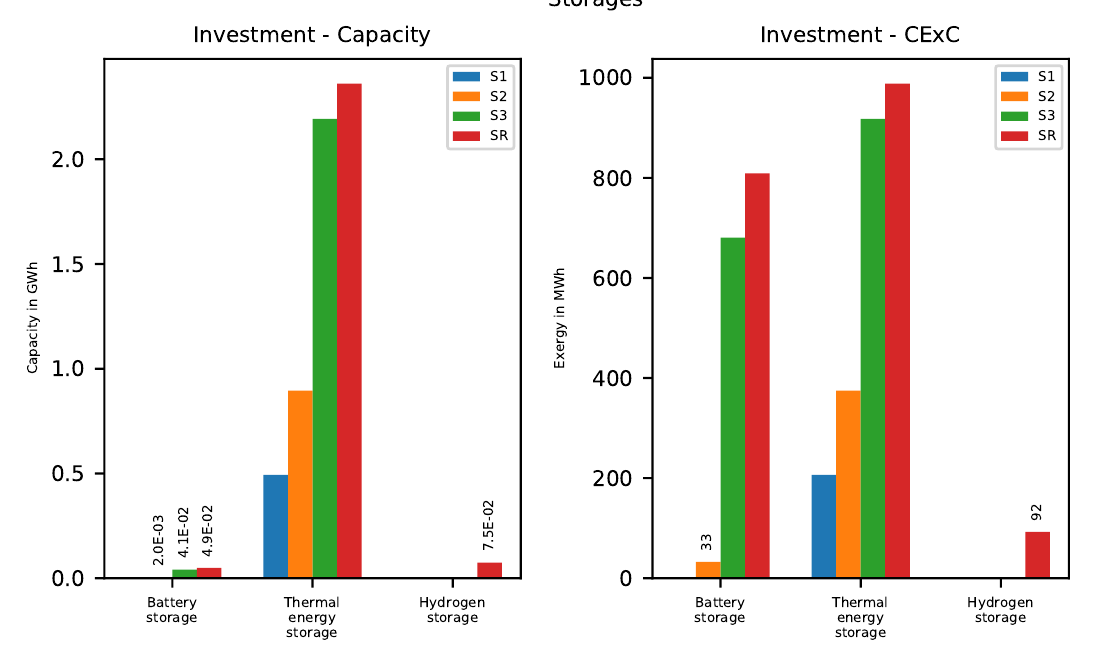
Figure 8. Calculated optimum storage capacities and the corresponding CExC. (Source: own